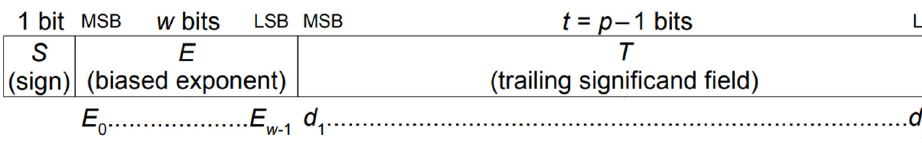
Figure 1. Diagram of IEEE 754 standard floating-point’s bit field.